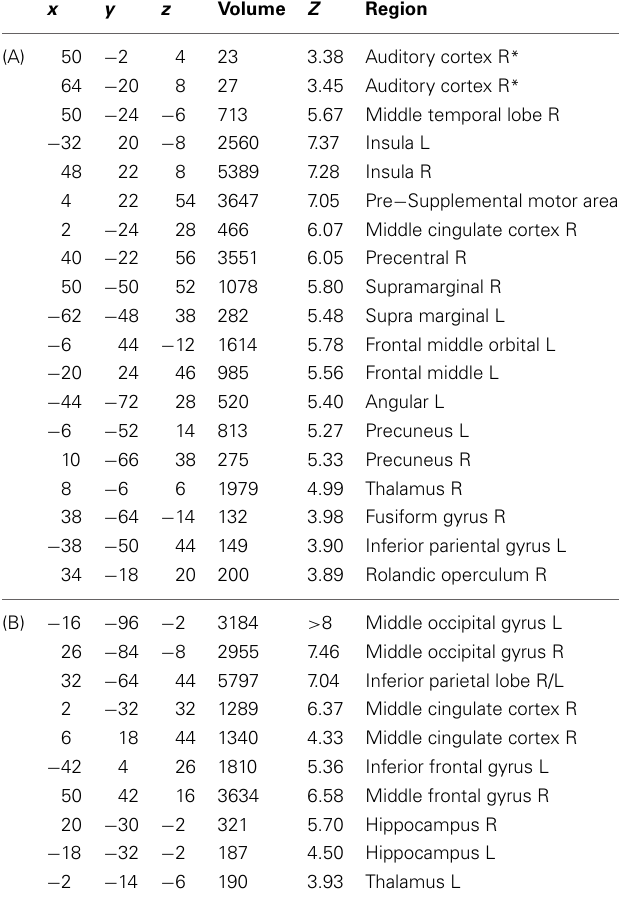
Table A1 | Brain regions showing neural activity during reinforcement in main effect of correctness (A) and interaction session x correct- ness (B).